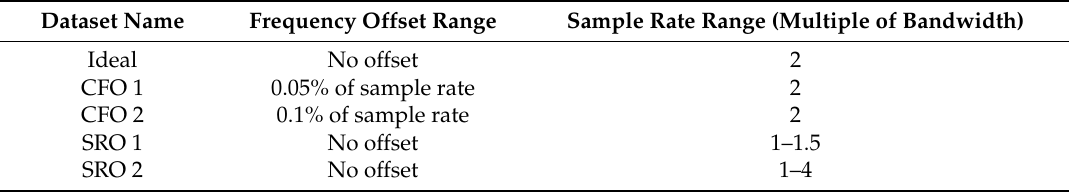
Table 1. Considered neural network training